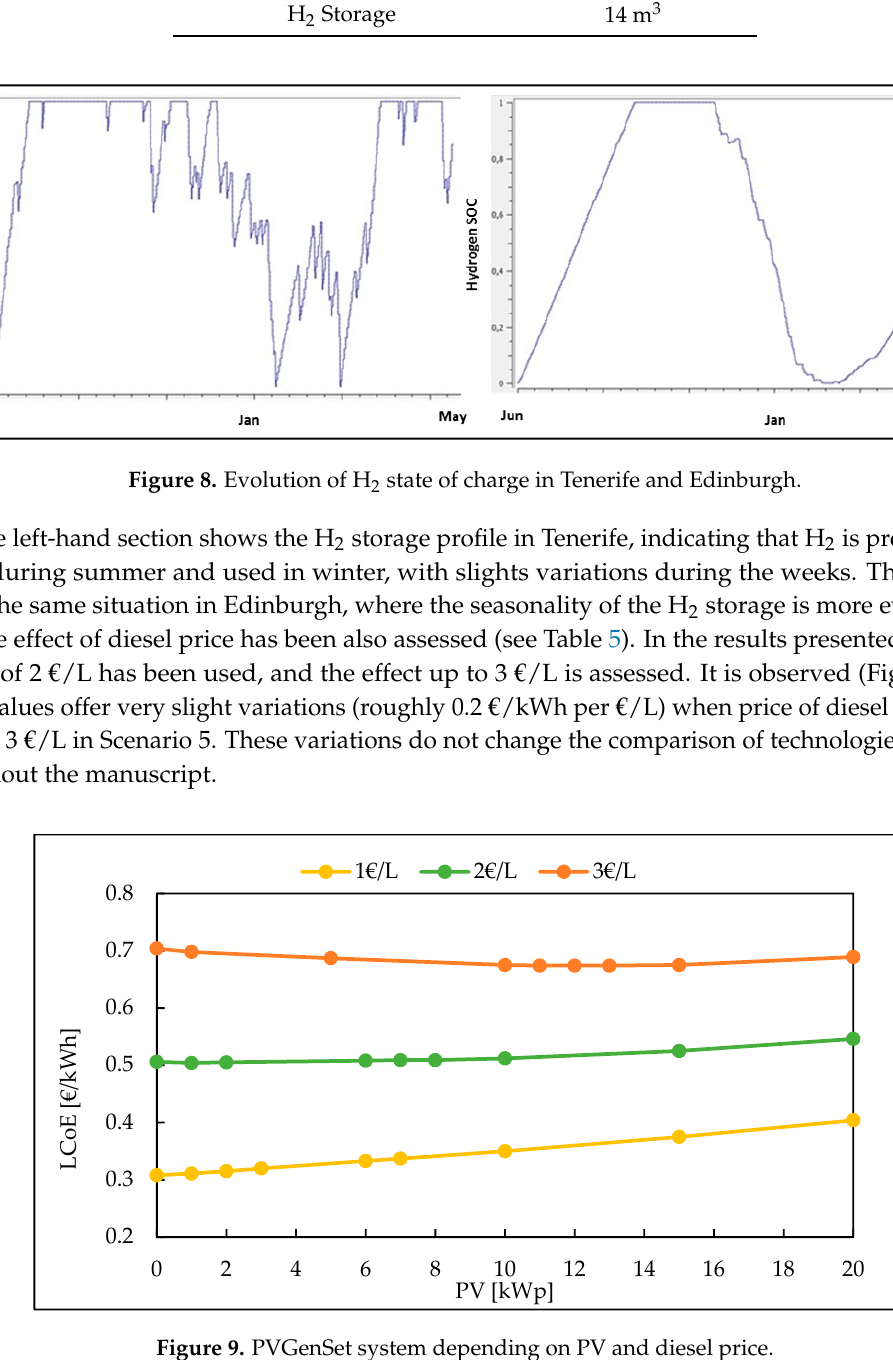
Figure 9. PVGenSet system depending on PV and diesel price.